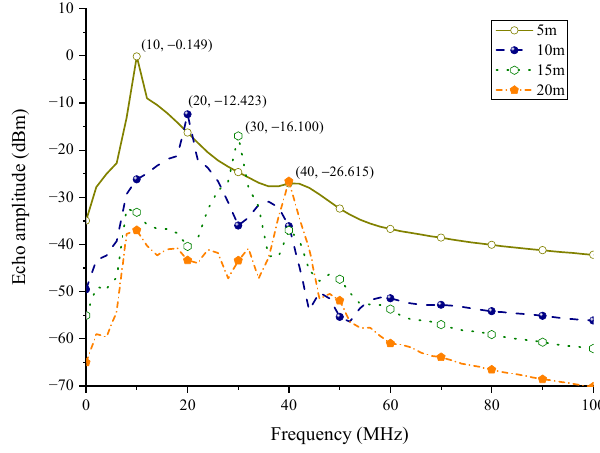
Figure 9. IF output spectrum.